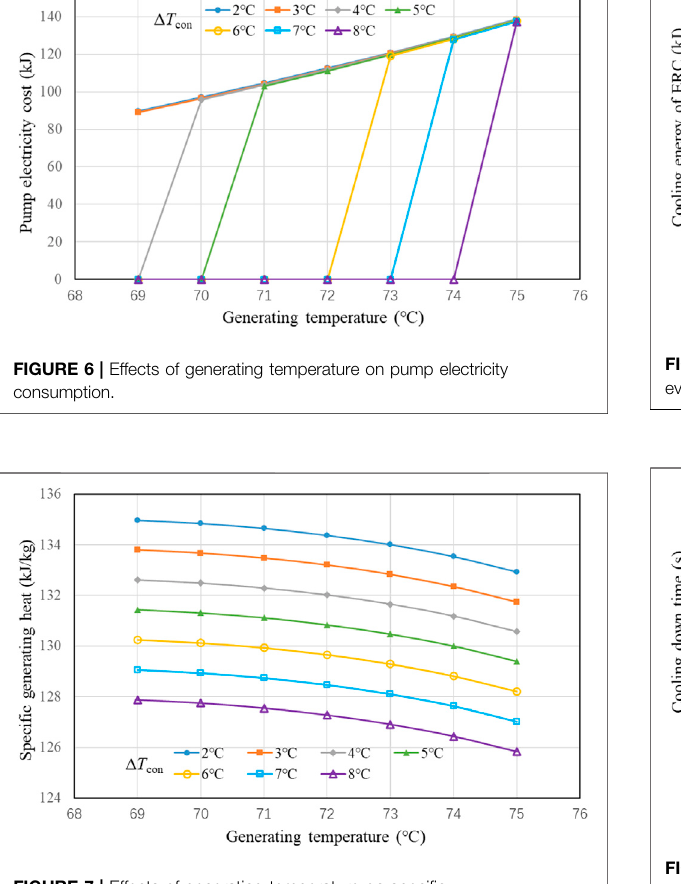
FIGURE 7 | Effects of generating temperature on speci fi c generating heat.